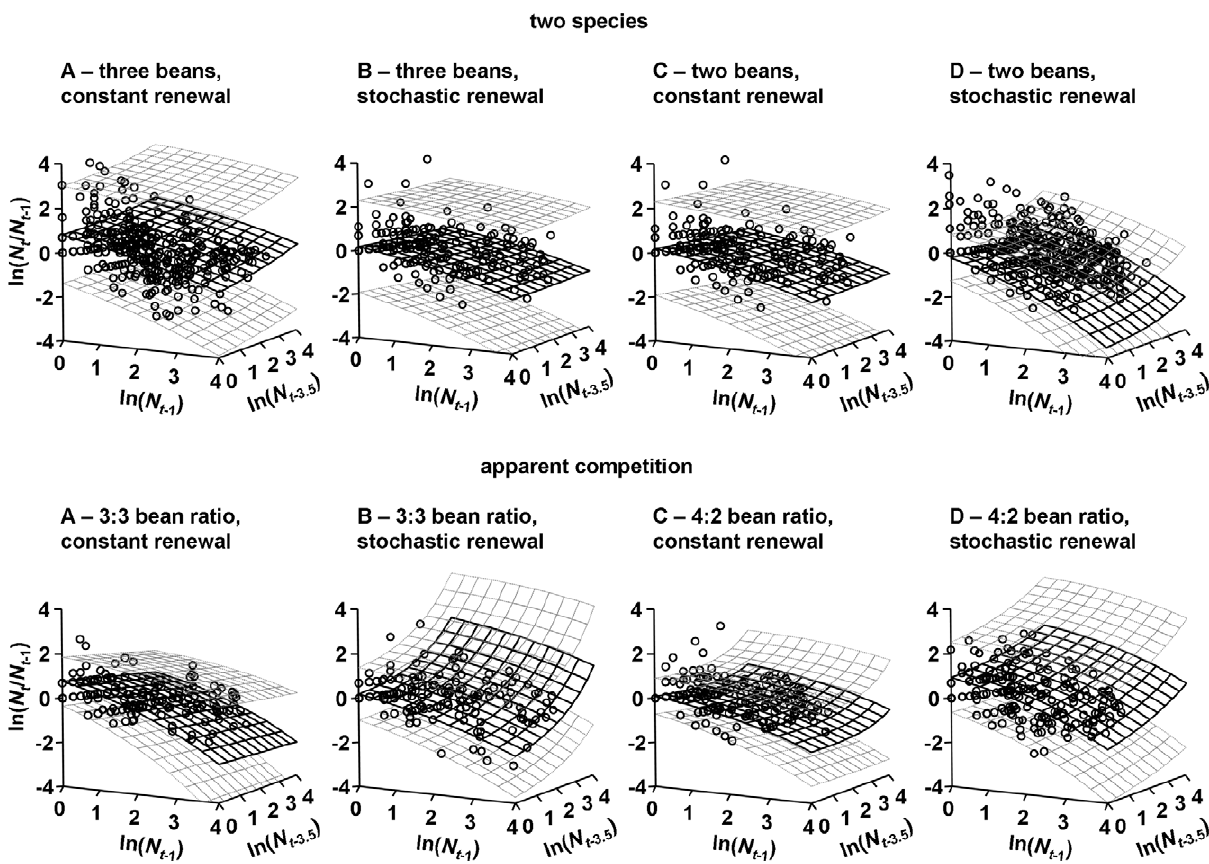
Figure 3. Predicted determinants of temporal density dependence in net reproductive rate, ln N t = Nt { 1 Þð , for C.maculatus . Using hierarchical mixed effects models, patchwise net reproductive rate was regressed against patchwise adult abundance covariates, N h weeks, with their respective optimised Box-Cox transformations, h . The two orthogonal lagged abundance covariates represent the best fitting within generation time lagged abundance ( t =1 week) and one generation time lagged abundance, ( t =3.5 weeks). Solid wireframe: maximum likelihood estimates. Grey, dotted wireframe: 95% confidence intervals.